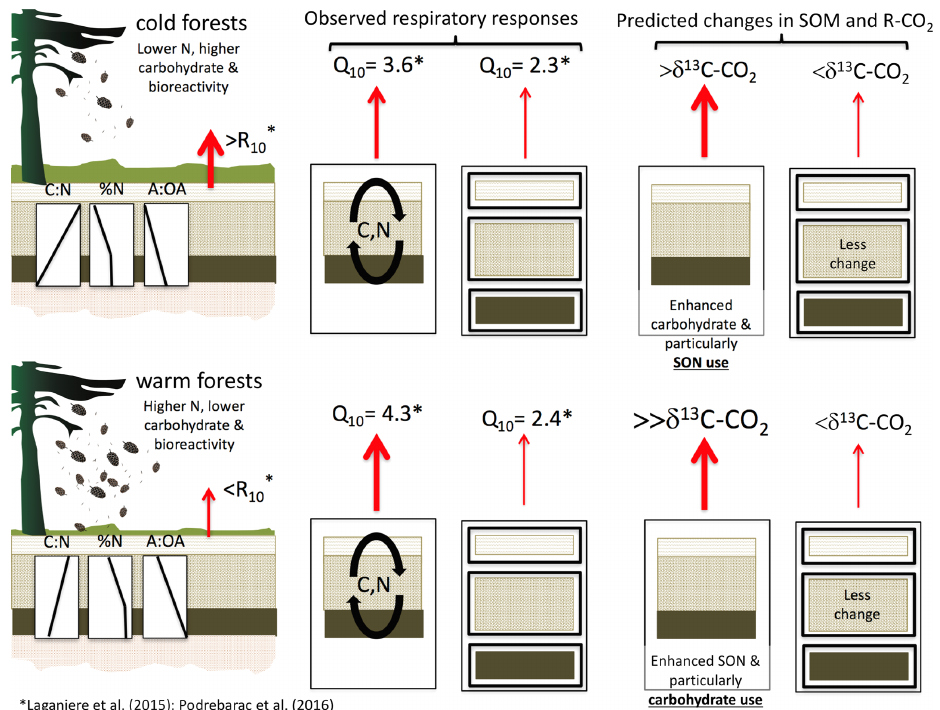
Figure 1. Conceptual figure depicting differences in relatively cold and warmer boreal forest organic horizon compositions, including biore- activity given as C-normalized soil respiration at 10 ◦ C ( R 10 ; left column), previously reported temperature sensitivities of heterotrophic respiration ( Q 10 ) in two incubation designs (“whole” versus “isolated”, left to right in center column; Podrebarac et al., 2016), and hypoth- esized responses of incubated soils with and without interlayer exchange of microbial C and N substrates (right column). The carbon to nitrogen (C:N) ratio, nitrogen content (as %N), and the alkyl to O-alkyl ratio (A:OA) reflect the decreasing relative content of carbohydrate with depth and in the warm relative to colder climate forest sites and decreasing N content with depth and in the colder sites (left side). En- hanced temperature sensitivity of respiration in the soils incubated as a whole profile relative to those same horizons incubated individually in isolation prompted hypotheses that (1) soils incubated as a whole profile, especially from the warmer forests, would experience greater relative losses of carbohydrates signified by more 13 C-enriched respired CO 2 ( δ 13 C-CO 2 ), increased ratio of alkyl-C to O-alkyl-C (A:OA), and reductions in C:N relative to the same soils incubated as isolated horizons, signifying a greater use of labile C in support of the enhanced temperature sensitivity of respiration; and that (2) soils incubated as a whole profile, especially from the colder forests, would experience a reduction in %N as total hydrolyzable amino acids, signifying a greater use of soil organic N in support of the enhanced temperature response of soil